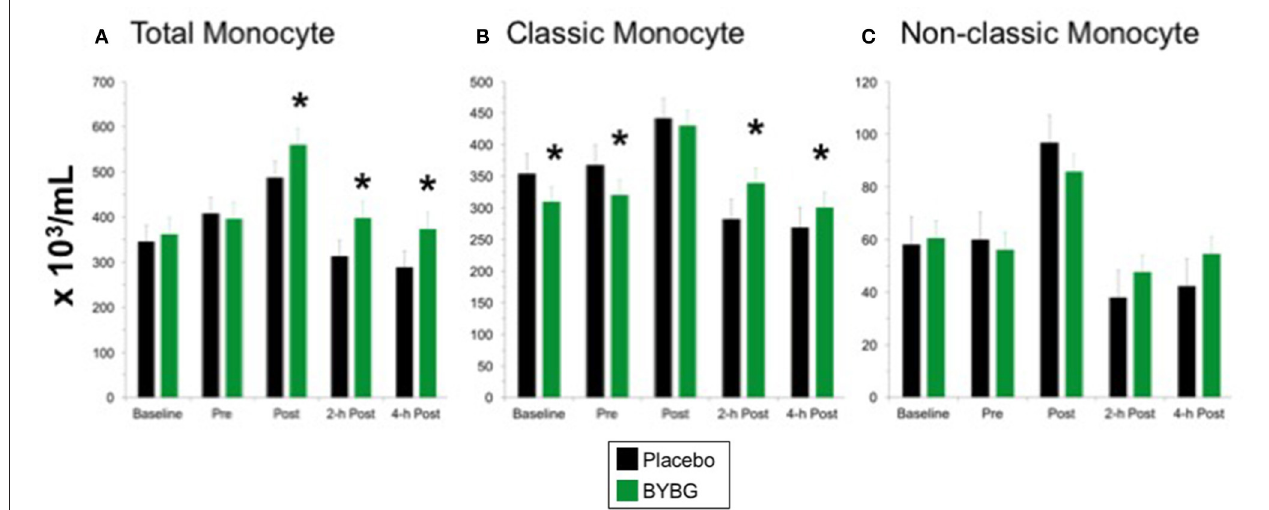
FIGURE 3 | Effect of BYBG on CD14 + cells in peripheral blood. Monocyte concentrations were determined using peripheral blood mononuclear cells (PBMC) isolated from human whole blood samples. PBMCs were analyzed using flow cytometry to determine total ( A , CD14 + ), classic ( B , CD14 + /CD16-), and non-classic ( C , CD14 + /CD16 + ) monocyte concentrations. Placebo (black bars) and BYBG (green bars) are represented separately and were statistically compared. Values represent the mean ± SEM. *indicates BYBG significantly different than placebo ( p <